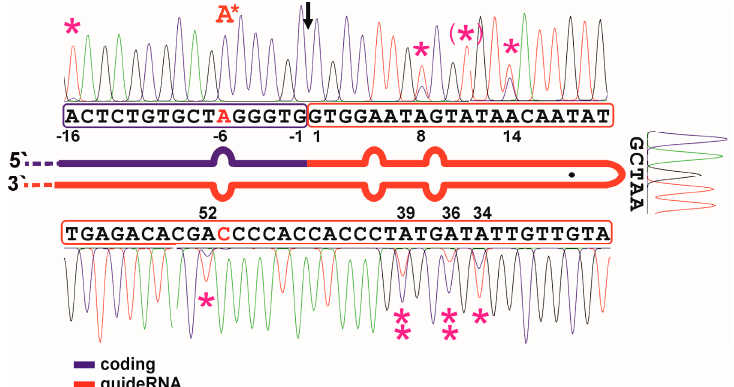
Figure 2. Identification of auto ‐ editing hotspots. An in ‐ vitro transcribed RNA substrate containing a part of the eCFP ORF around the W66x site (blue) in cis with an R/G ‐ guideRNA (red) was edited with a purified ADAR2 enzyme in a PCR tube. Hotspots for auto ‐ editing have been marked by magenta asterisks; double asterisks mark strongly edited sites; asterisk in brackets mark an editing site only found in a similar experiment inside the cell (see Figure S4). The red A* marks the targeted editing site, full conversion was achieved. The black arrow shows the site where the cistronic motif is cut when the guideRNA is applied in trans.